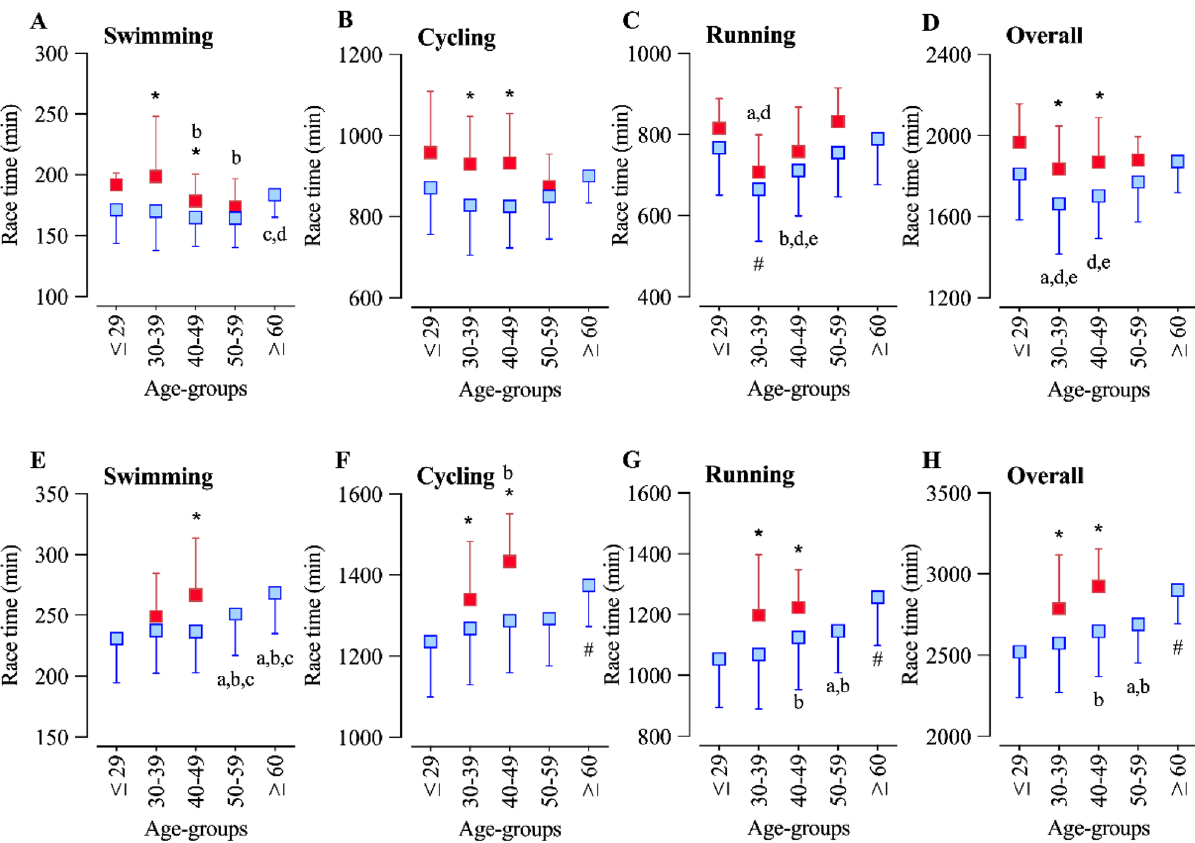
Figure 2. Race performance (minutes) by age groups of men and women competing in Double Iron ( A – D ) and Triple Iron ( E – H ) ultra-triathlon. *: different between sex, within the same age group, #: different from all the other age groups, a: different from age group ≤ 29 years, b: different from age group 30–39 years, c: different from age group 40–49 years, d: different from age group 50–59 years, e: different from age group ≥ 60 years.